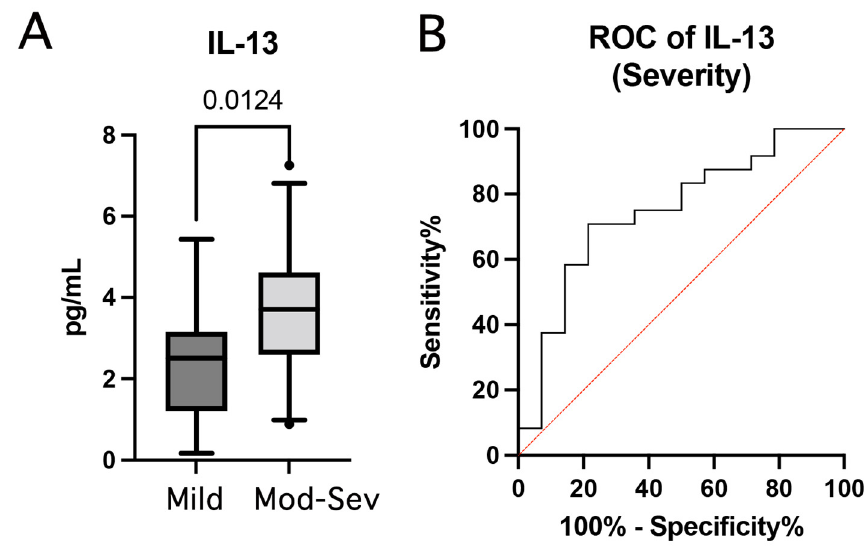
Figure 4. Inflammatory biomarkers as predictors of TBI severity. ( A ) Box and whisker plots showing the protein levels in pg/mL of IL-13 as a biomarker of injury severity. Box and whiskers are shown for the 5th and 95th percentile. Dots correspond to data points outside the 5th and 95th percent confidence interval. ( B ) ROC curves indicate the AUC (sensitivity vs. 1-specificity) for IL-13. Mild: N = 14, Moderate to severe: N = 24.